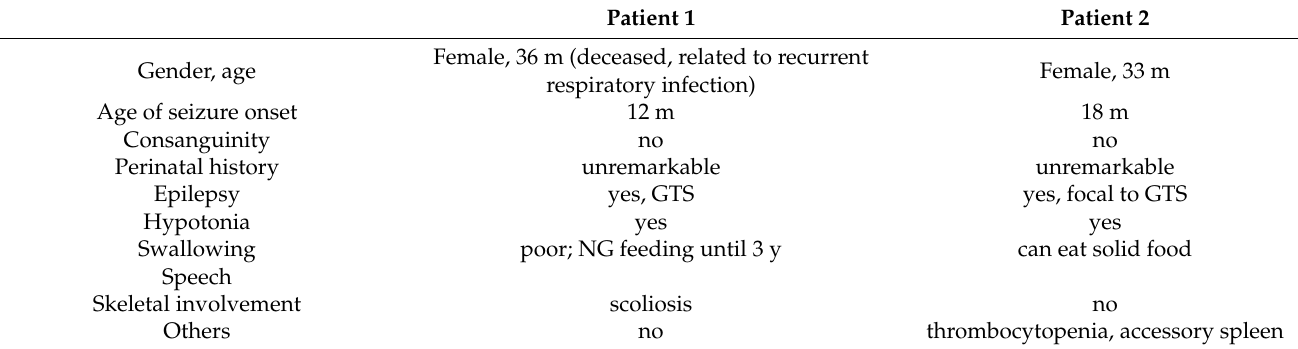
Figure 2. The T1-weighted, sagittal section of brain MRI from patient 2 also shows marked thinning of the corpus callosum ( a ). The T2-weighted, axial section shows prominent enlargement of cerebral cortical sulci and ventricles ( b ). Table 1. Clinical presentation of patients with compound heterozygous TBCD mutations in this study.